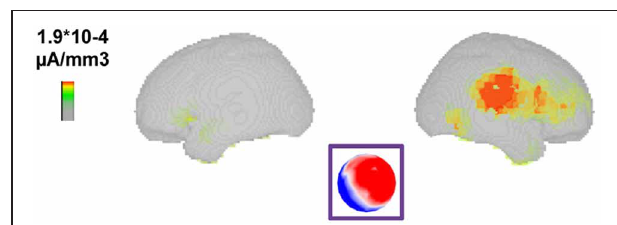
FIGURE 3 | LAURA distributed source estimations corresponding to the topography identified as best characterizing the pre-stimulus period before correct rejections identified a right hemispheric fronto-temporal prestimulus activation.